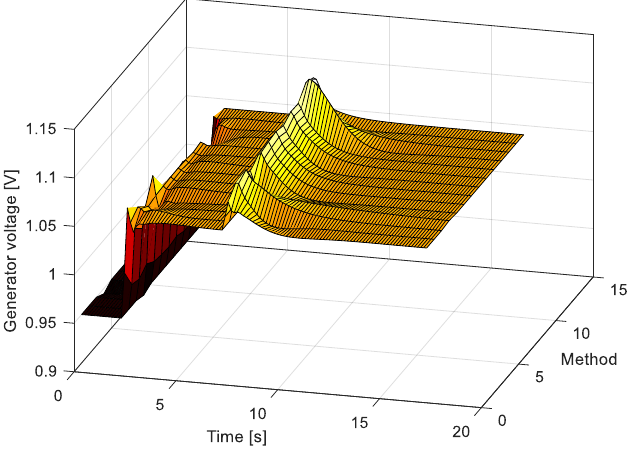
Figure 9. Step responses obtained using the regulator parameters given in Table 5. The generator voltage responses are depicted in Figure 10 using the regulator param- eters obtained using the proposed method and SA-MRFO presented in [6]. These re- sponses were obtained for changes in the generator voltage reference value and excitation voltage disturbance. Thus, from the responses presented, it is clear that the proposed SA- GTO enables the best system responses.